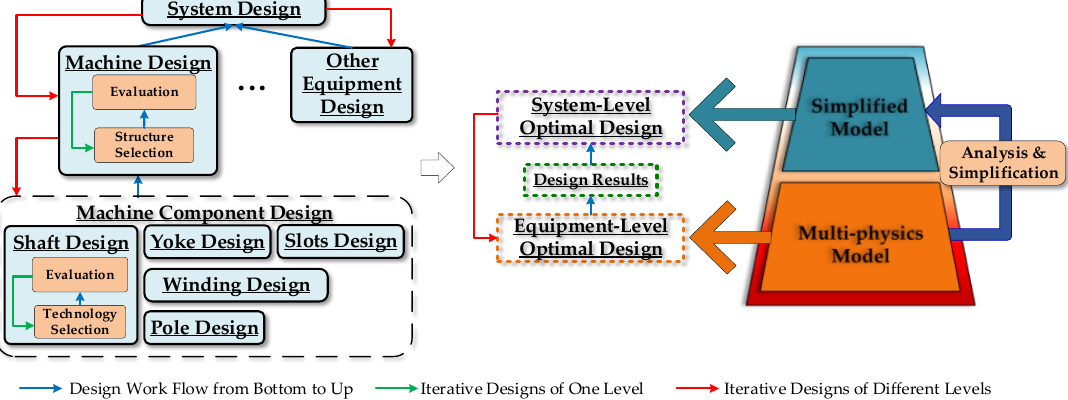
Figure 1. The hierarchical design process of a More-electric system and required evaluation models.